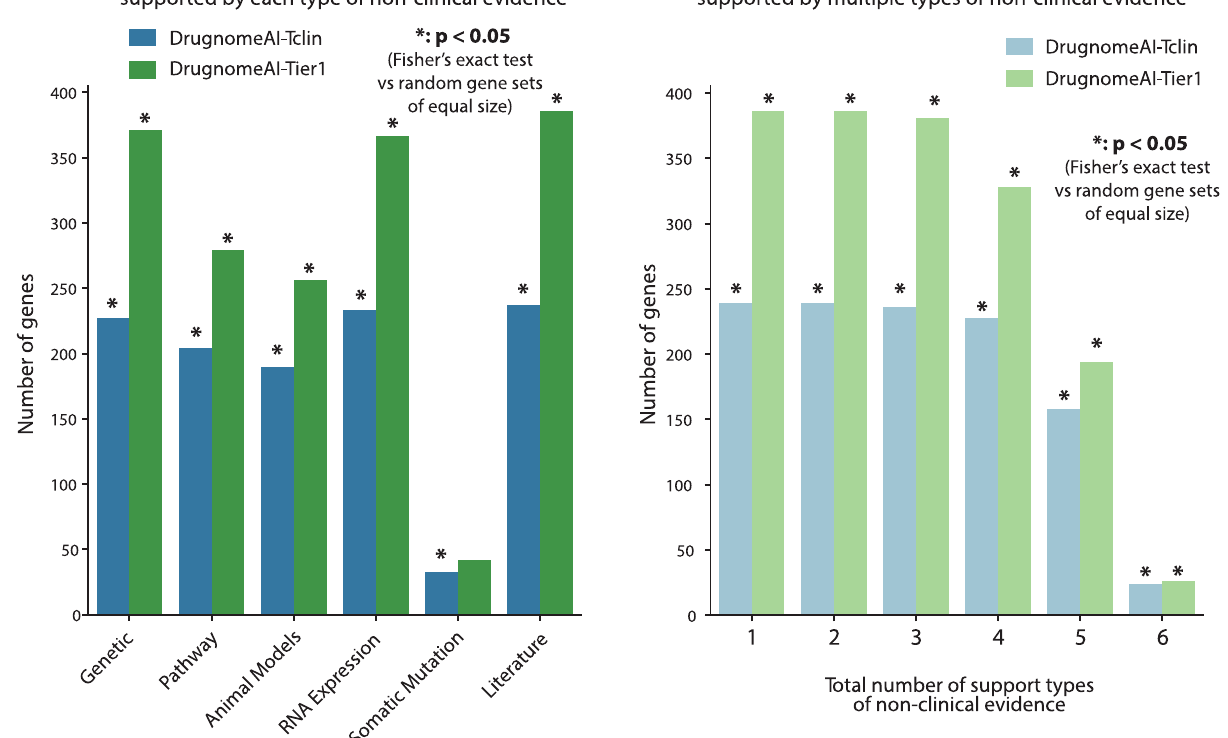
Fig. 4 Clinical and non-clinical evidence for the top 5% of genes ranked by DrugnomeAI. Clinical evidence available for the top 5% genes ( n = 992) ranked by ( a ) DrugnomeAI-Tclin and ( b ) DrugnomeAI-Tier1. Each bar indicates the number of genes targeted by each molecule type per clinical trial phase. c Number of genes among the top 5% DrugnomeAI Tclin-based and Tier1-based predictions satisfying each distinct type of non-clinical evidence. d Number of genes among the top 5% DrugnomeAI Tclin-based and Tier1-based predictions satisfying multiple types (x = 1,2,..6) of non-clinical evidence. Asterisks (*) denote that the respective gene sets are signi fi cantly enriched for each type or set of types of non-clinical evidence compared to 10 random gene sets of equal size (the median p value is eventually used to assess signi fi cance in each case).